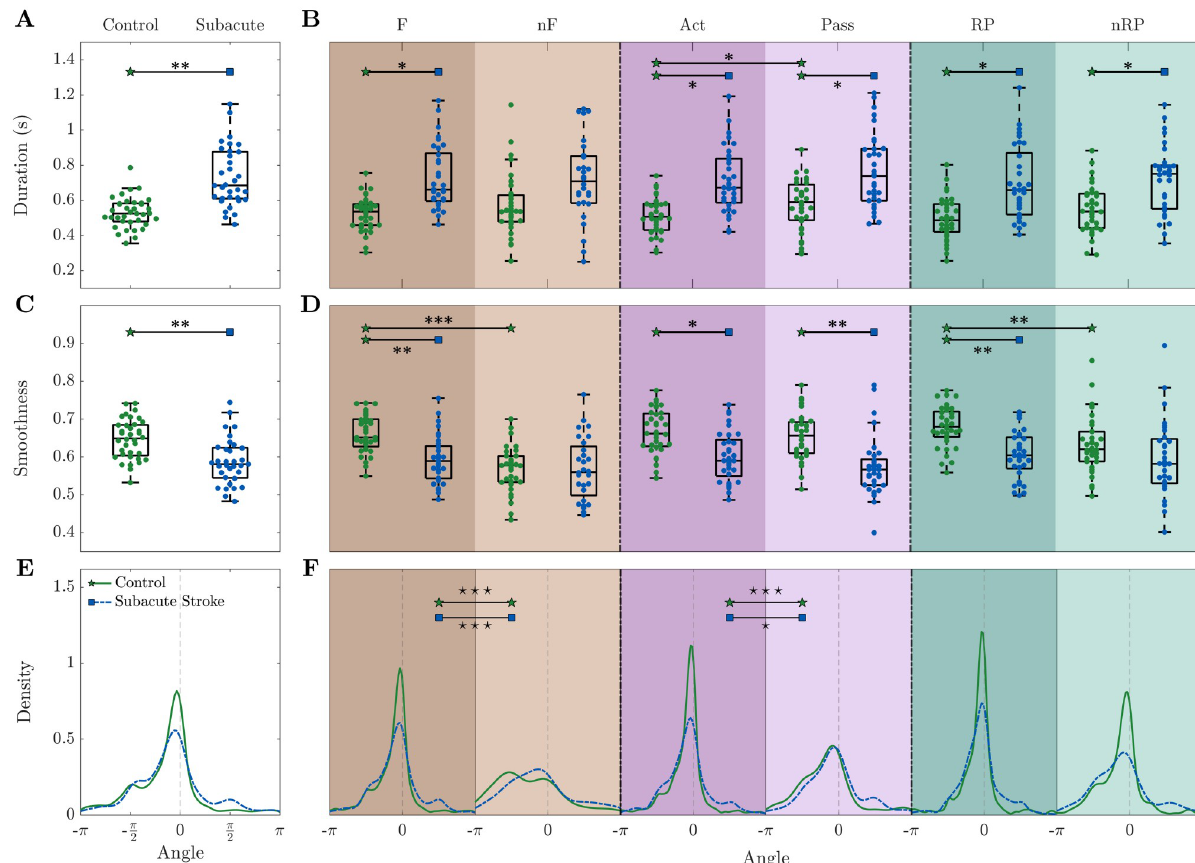
Fig 5. The subacute phase (one week after stroke) is characterized by an increase of the event duration and decrease of smoothness. During the subacute phase, (A-B) the event duration is increased, (C-D) smoothness is decreased, and (E-F) the direction of propagation is more spread.—Results refer to the first week of recording after stroke. Duration and angle are weighted by smoothness. Markers in (A-D) refer to the average value per day. In (A,C) each point is the average of all events per day per mouse, while in (B,D) each point is the average of all events of a specific type per day per mouse. Within each box in (A-D), the central mark indicates the median, and the bottom and top edges of the box indicate the 25 th and 75 th percentiles, respectively. Control n = 8 mice, Subacute Stroke n = 8 mice. See S2 Table for p-values of statistical tests, “ ? ” refers to difference in variance and “ � ” refers to difference in